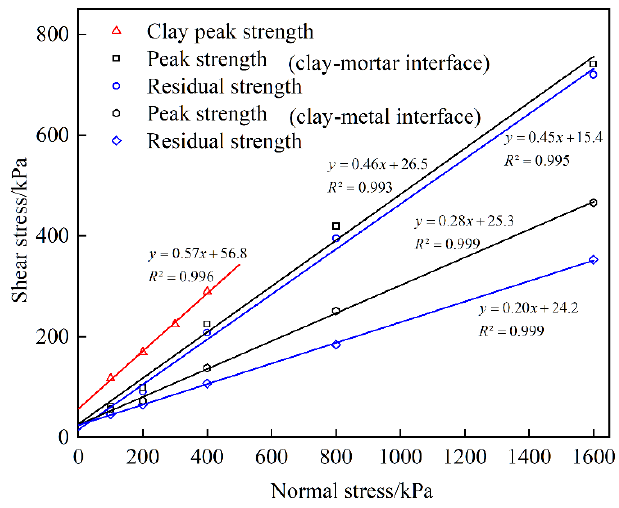
Figure 8. Relationships between normal stress and shear stress.